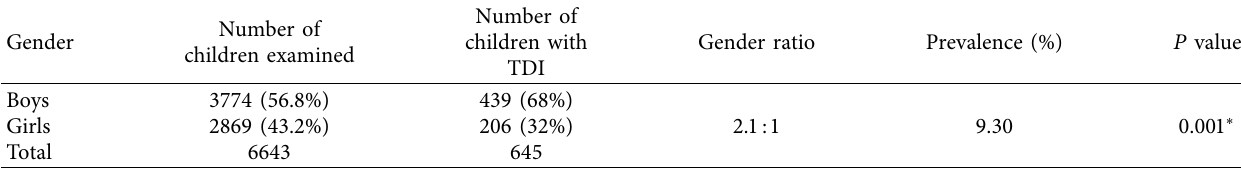
Table 2: Boys:girls ratio and the prevalence of boys with anterior teeth fracture.